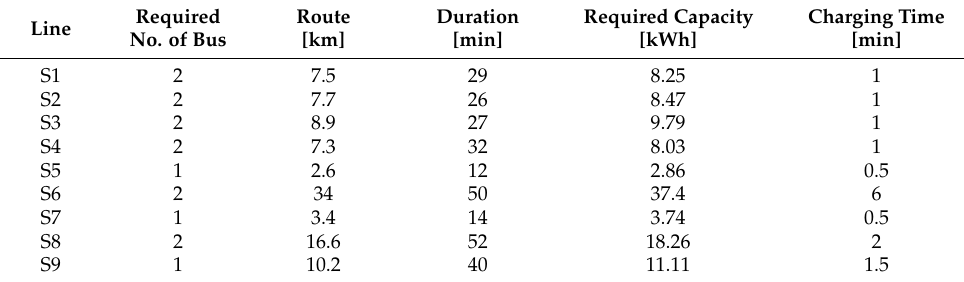
Table 3. Line information of line S5 and S7 for 2 buses scenario.